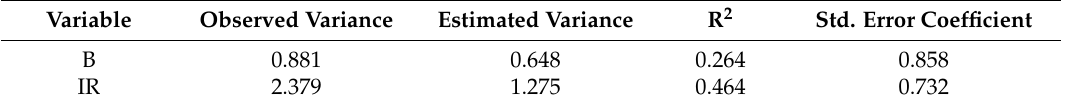
Table 10. Model R 2